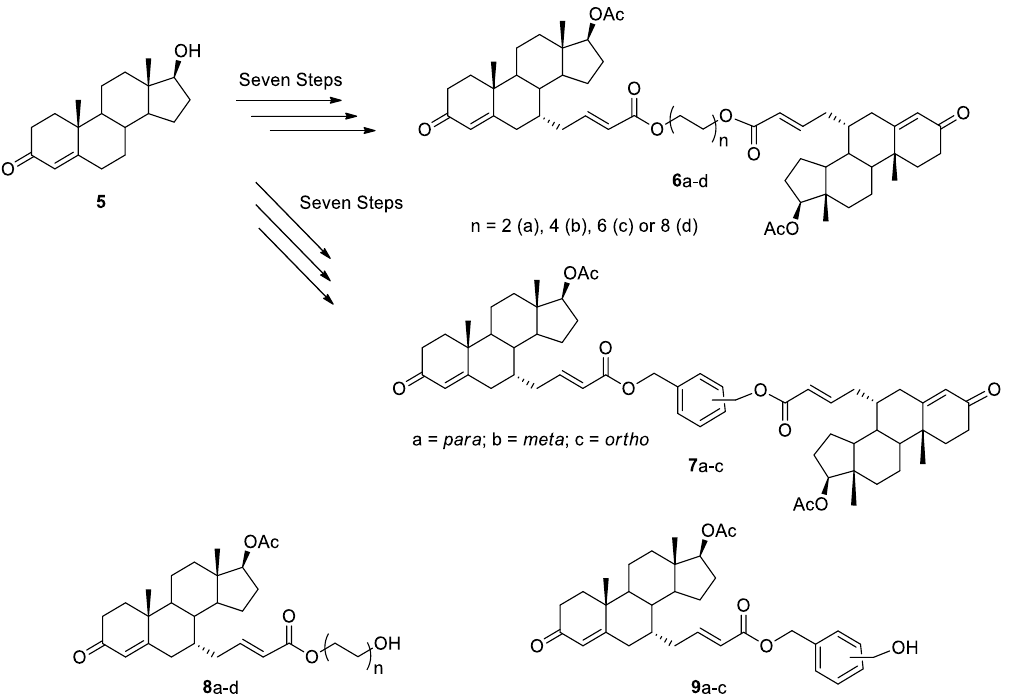
Figure 3. Synthesis of C2 -symmetric testosterone dimers 6a – d and 7a – c by esterification reaction and their precursor’s 8a – d and 9a – c .